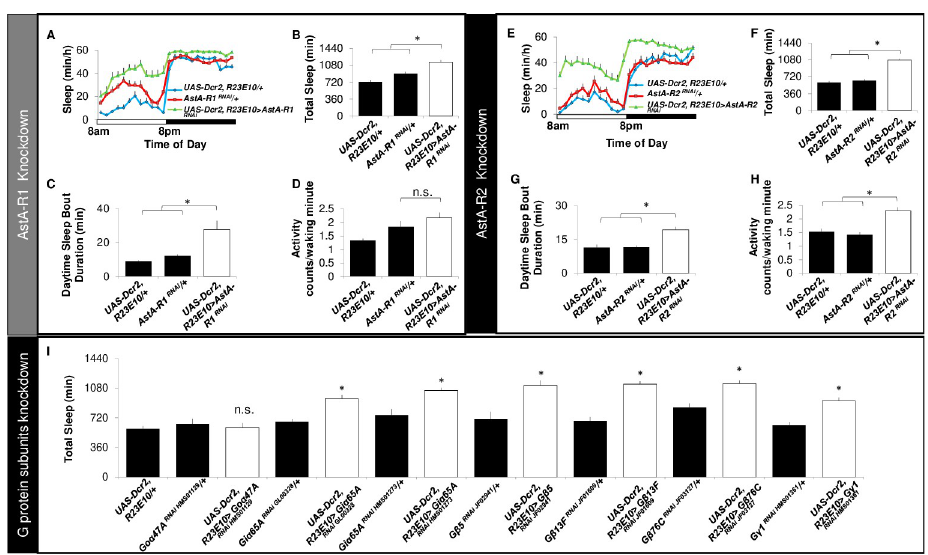
Fig 2. Knocking down AstA-R1 or AstA-R2 in R23E10 neurons increases sleep. ( A ) Sleep in minutes per hour, ( B ) total sleep, and ( C ) daytime sleep-bout duration are increased when AstA-R1 is knocked down in R23E10 neurons compared with both UAS-Dcr2 , R23E10-GAL4/+ , and AstA-R1 RNAi /+ parental controls ( n = 16/condition, � p < 0.05, modified Bonferroni test). ( D ) Waking activity is not different between UAS-Dcr2 , R23E10-GAL4/+ > AstA-R1 RNAi /+ experimental flies, and both UAS-Dcr2 , R23E10-GAL4/+ , and AstA-R1 RNAi /+ controls ( n = 16/condition, p > 0.05, modified Bonferroni test). ( E ) Sleep in minutes per hour, ( F ) total sleep, and ( G ) daytime sleep bout duration are increased when AstA-R2 is knocked down in R23E10 neurons compared with both UAS-Dcr2 , R23E10-GAL4/+ , and AstA-R2 RNAi /+ parental controls ( n = 16/condition, � p < 0.05, modified Bonferroni test). ( H ) Waking activity is significantly increased in UAS-Dcr2 , R23E10-GAL4/+ > AstA-R2 RNAi /+ experimental flies compared to both UAS-Dcr2 , R23E10-GAL4/+ , and AstA-R2 RNAi /+ controls ( n = 16/condition, p < 0.05, modified Bonferroni test). ( I ) Total sleep is not changed when Go α 47A levels are reduced in R23E10 neurons, but independently knocking down Gi α 65A , G β 5 , G β 13F , G β 76C , and G γ 1 in R23E10 cells increase total sleep compared with parental controls ( n = 16/ condition; � p < 0.05). Error bars represent SEM. Underlying data is in S2 Data and S1